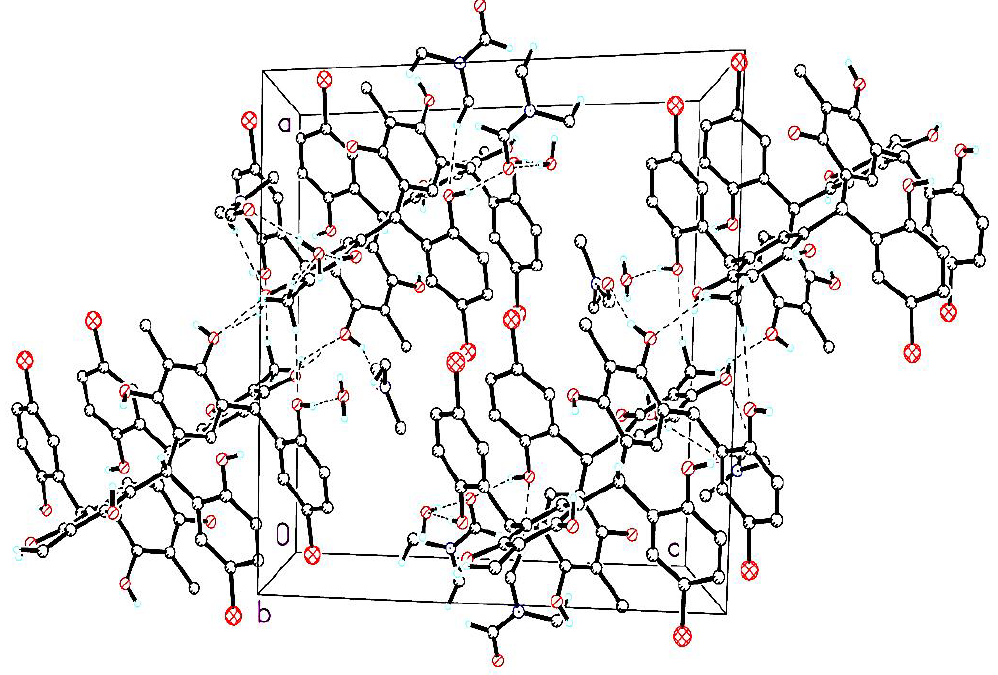
Figure 3. Molecular packing of C-5-bromo-2-hydroxyphenylcalix[4]-2-methylresorcinarene, viewed down the b axis. Dashed lines denote O—H …. O and C—H …. O hydrogen bonds and the non-hydrogen bonded atoms are omitted for